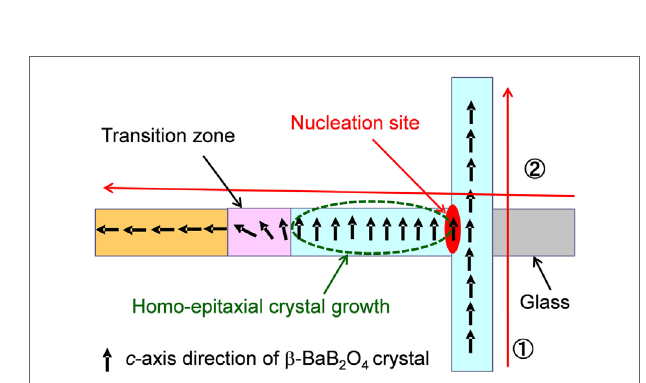
FigUre 7 | POM photograph focusing the crossing points of the first and second lines .